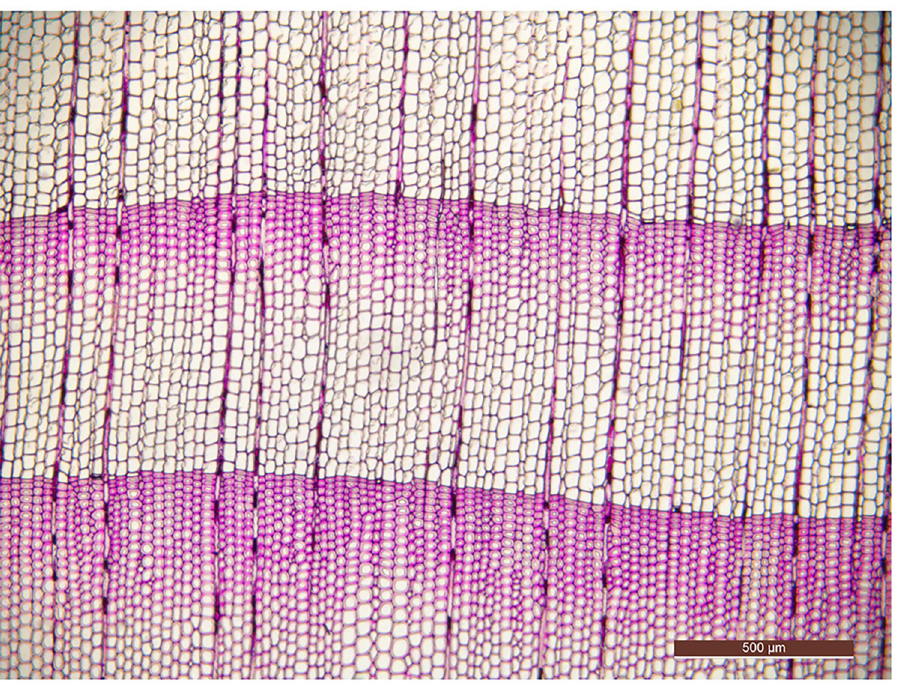
Fig 1. Cross-section of Tsuga chinensis var. forrestii